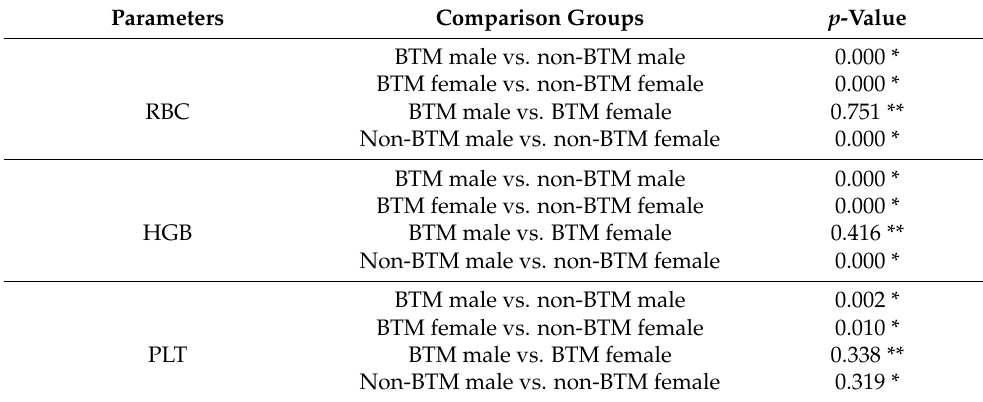
Table 3. Comparison of the statistical analysis results of the blood sample features between the groups (* Mann–Whitney U test, ** Student’s t -test).